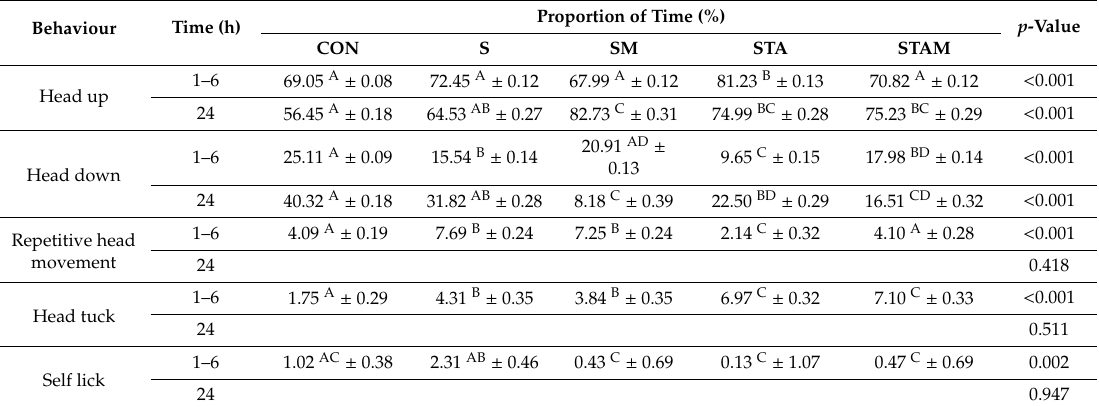
Table 4. Proportion of time spent exhibiting various head positions or movements ( ± SE) by heifers in each treatment group at 1–6 h and 24 h